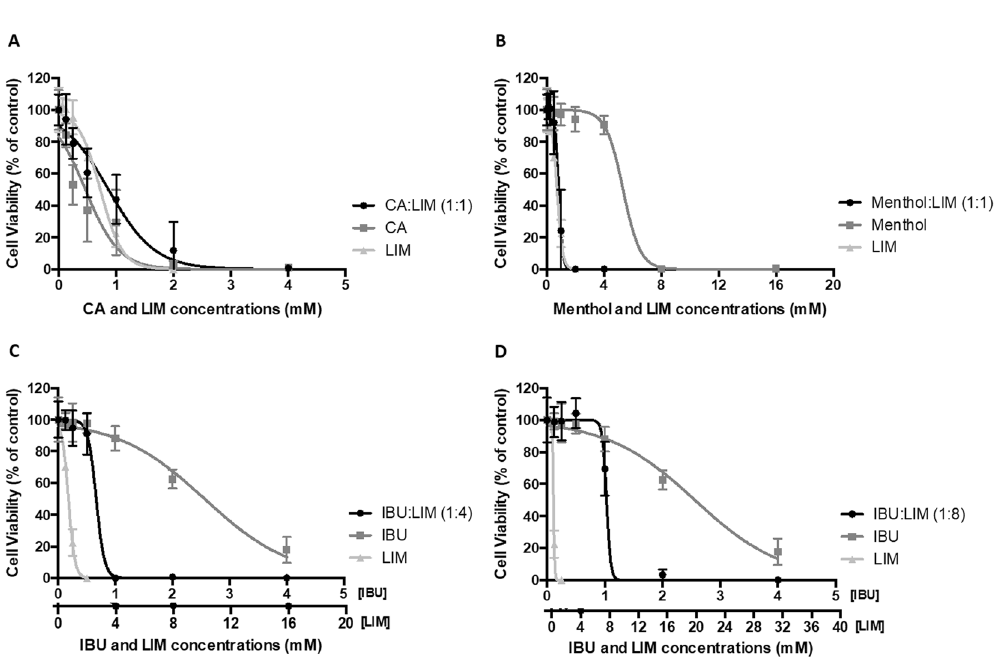
Figure 2. Antiproliferative effect of ( A ) CA:LIM (1:1), ( B ) menthol:LIM (1:1), ( C ) IBU:LIM (1:4) and ( D ) IBU:LIM (1:8) using HT29 cell model. Results were expressed relatively to the control as mean ± SD of at least three independent experiments performed in